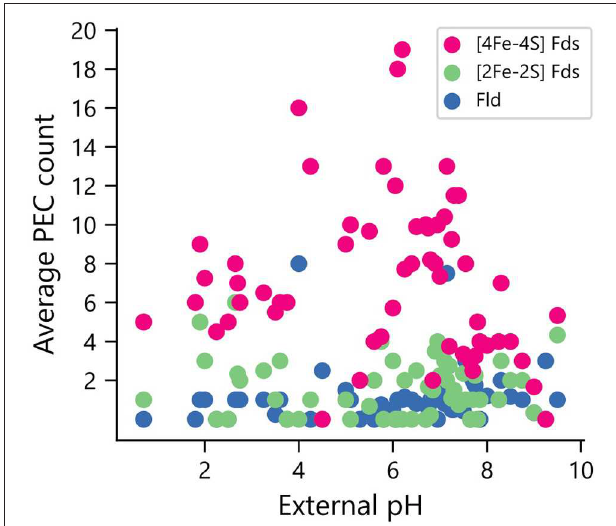
FIGURE 8 | Relationship between environmental pH and PEC gene counts. The distribution of PEC gene counts is normalized by the number of organisms found to grow at each pH value to obtain weighted averages of each PEC type. Analysis of the means revealed no significant pairwise differences using a paired two-tail t -test ( p = 0.126 for [2Fe-2S] Fd and Fld comparison, p = 0.163 for [4Fe-4S] Fd and Fld comparison, and p = 0.75 for [2Fe-2S] and [4Fe-4S] Fd